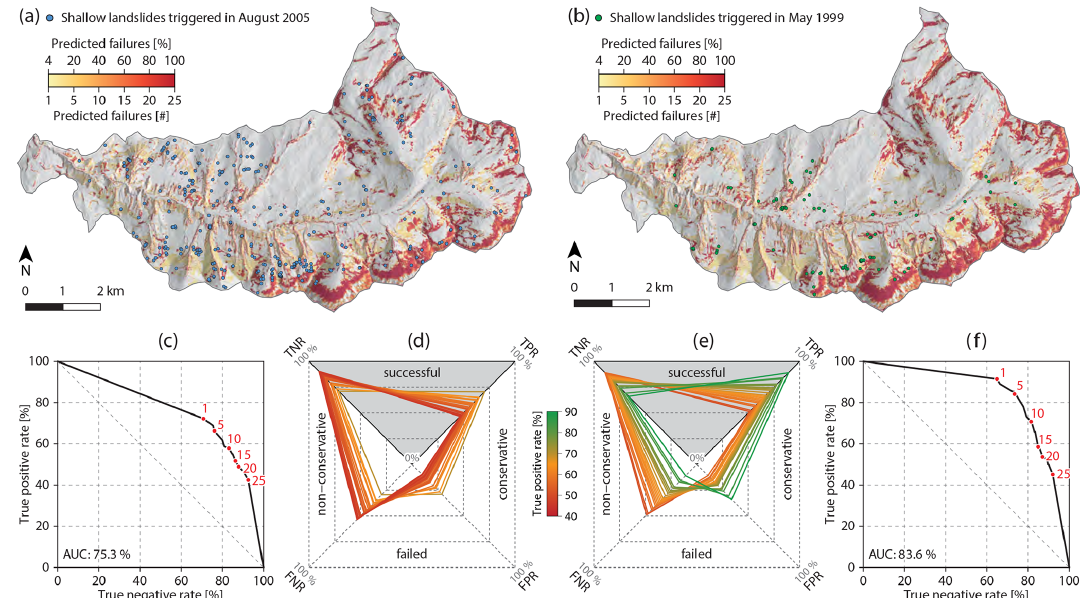
Figure 11. Predictive performance of the model ensemble. The maps show areas predicted to fail in response to the rainfall event in August 2005 (a) and in May 1999 (b) . The colours indicate the number of model runs predicting the respective areas to fail. The ROC plots likewise show the coordinates of the correctly predicted landslides and non-landslides for August 2005 (c) and May 1999 (f) associated with the number of model runs which are in agreement. The predictive rates of the model ensemble (see Table 8) are visualized for August 2005 (d) and May 1999 (e) . The colours indicate the true positive rate. TPR: true positive rate; TNR: true negative rate; FPR: false positive rate; FNR: false negative rate; AUC: area under the ROC curve.